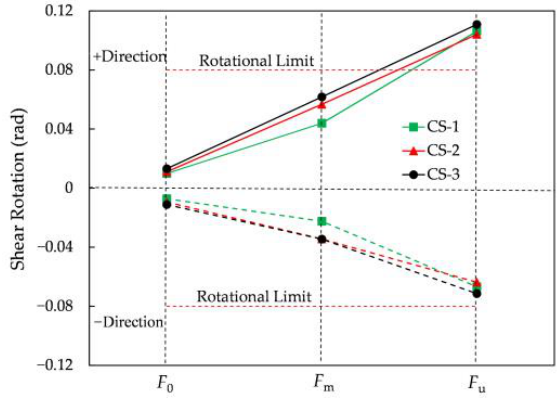
Figure 21. Shear rotation of SCBs. Table 6. Calculated shear rotation of SCBs (unit: rad).